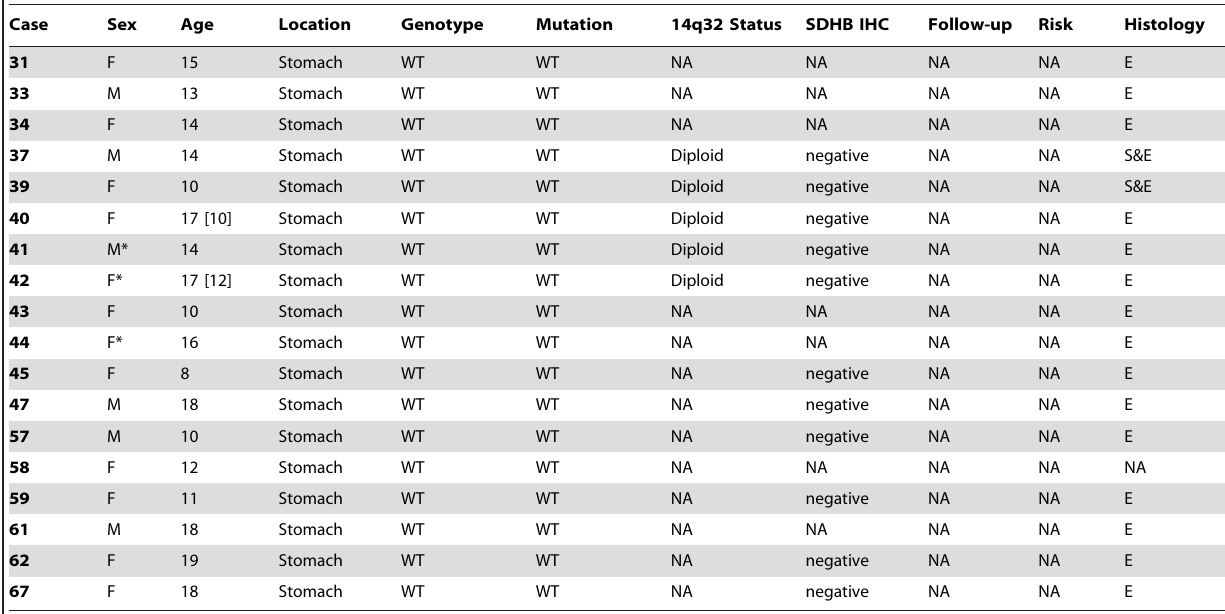
Table 3. Pediatric GIST case demographics.